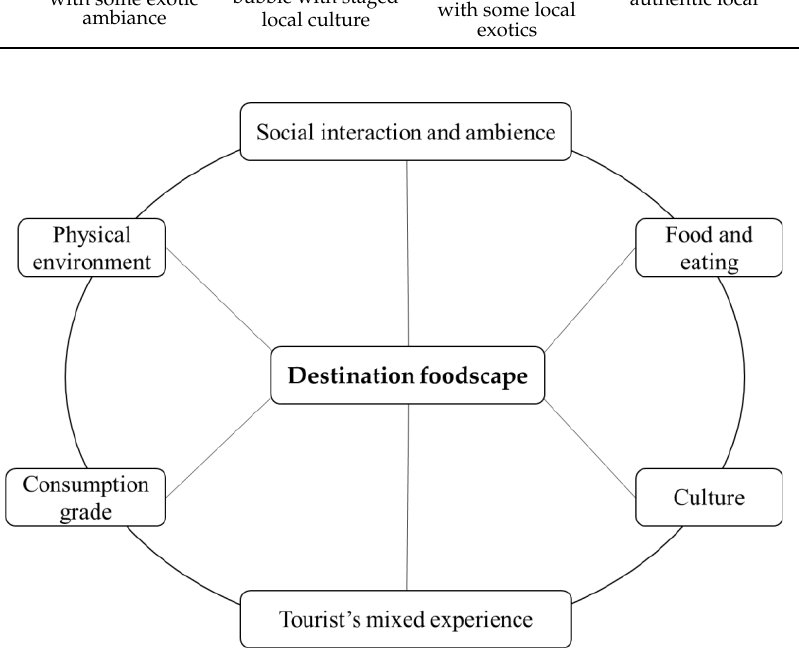
Figure 7. The dimensional construct of destination foodscape.